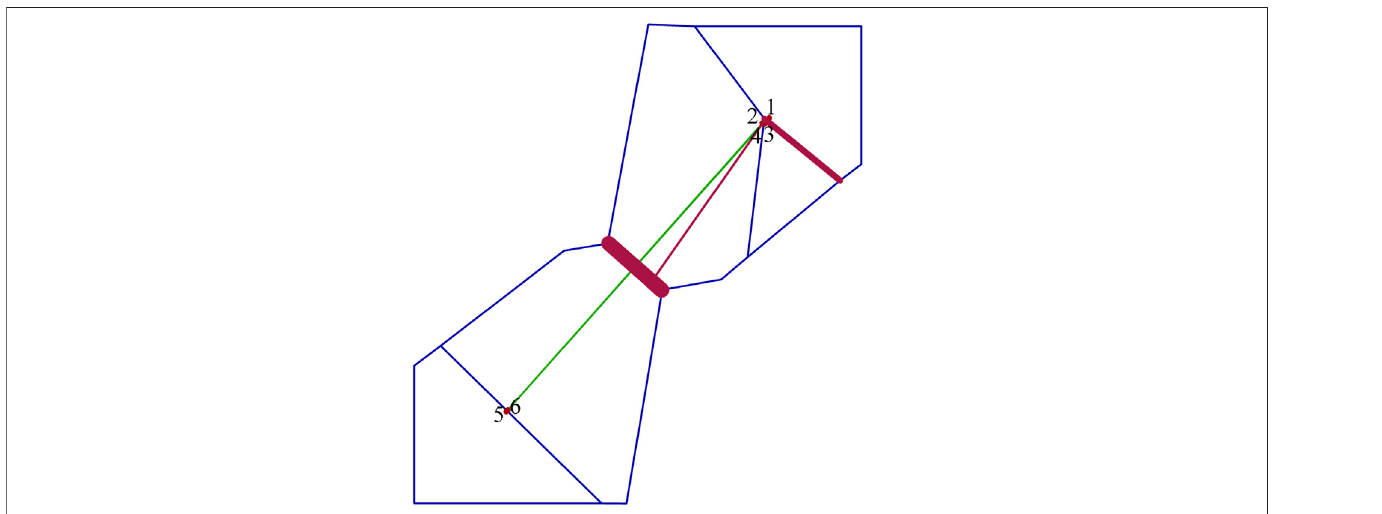
FIGURE 5 | Delaunay triangulation (in green) and Voronoï tessellation (in blue) of the barrier analyses for Xanthocyparis vietnamensis . Barriers (in dark red) are detectedwithbootstrapvaluesof100replicatesusingNei ’ sstandardgeneticdistance.Redpointscorrespondtothesixsamplingsites(1,N1;2,N2;3,N3;4,N4;5,S1; 6, S2).